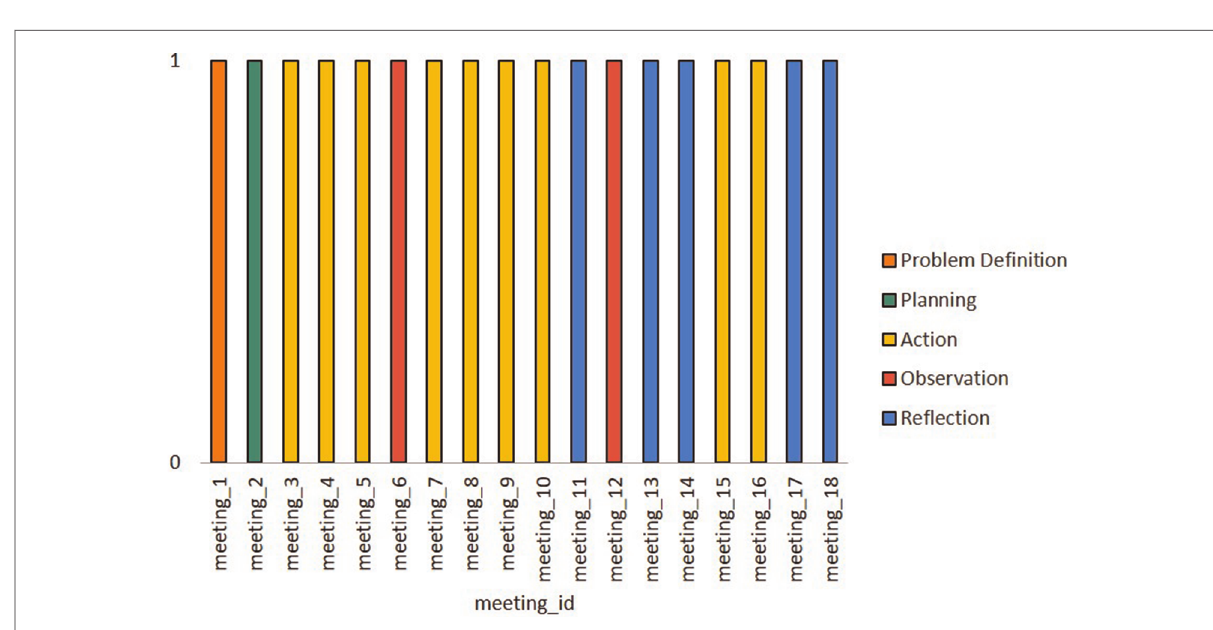
FIGURE 5 Distribution of meetings per